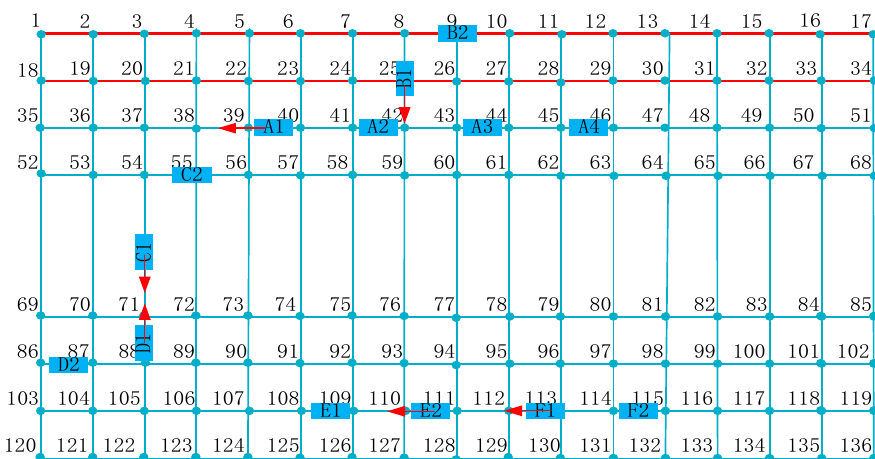
Figure 4. Path node network of IGVs.